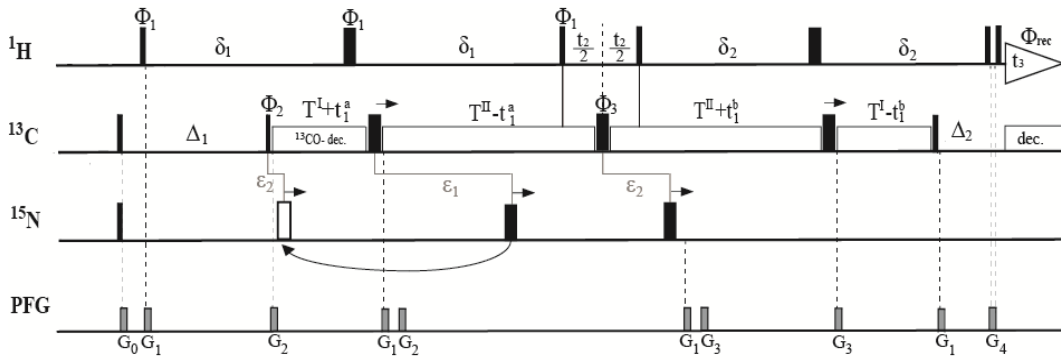
Figure 1. Pulse scheme for the three-dimensional (3D) HACAHB-COSY experiment for the measurement of three-bond H α –H β J-couplings ( 3 J Hα–Hβ ). The 1 H, 13 C, and 15 N carriers were positioned